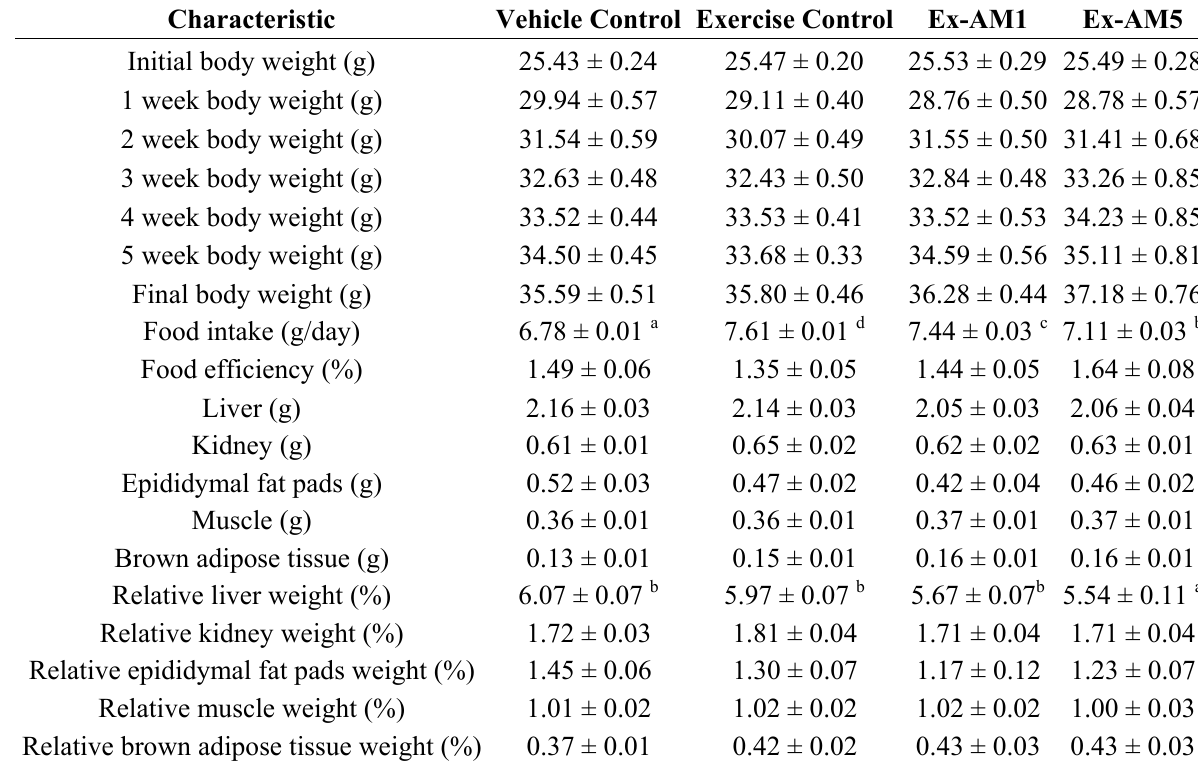
Table 1. General characteristics of the experimental